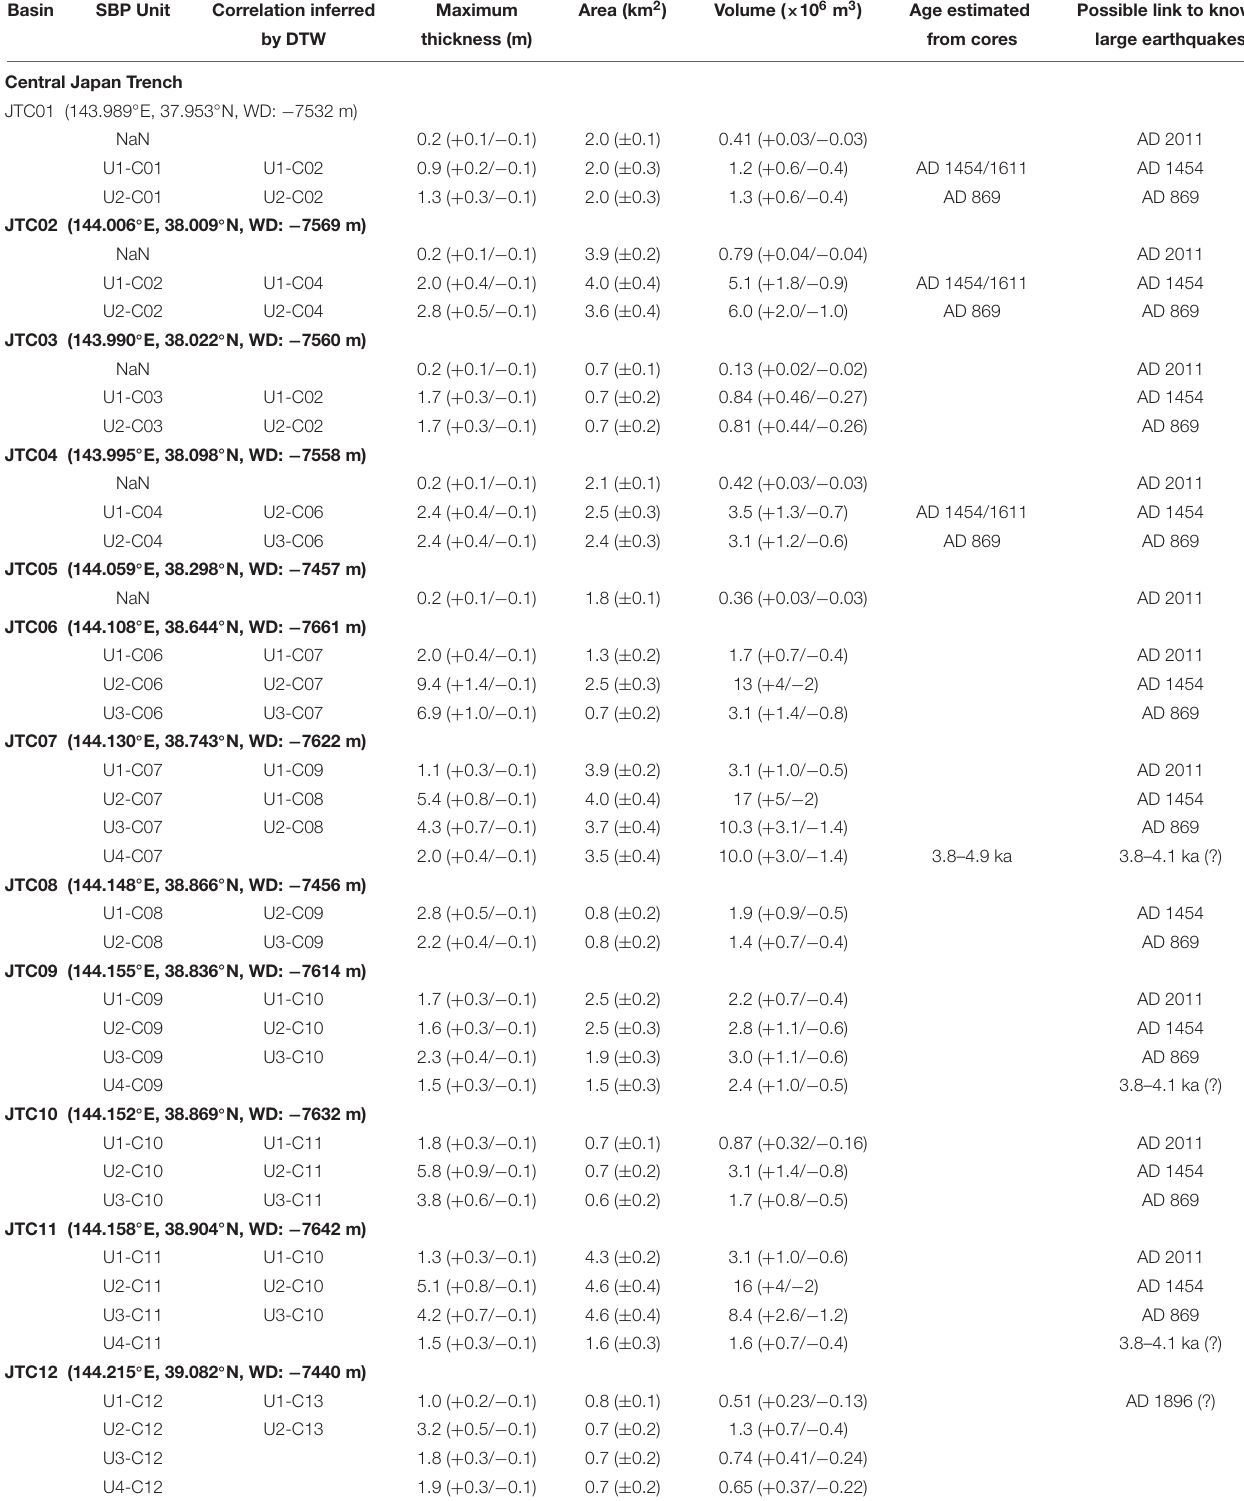
TABLE 2 | Longitude, latitude and water depth (WD) of modern depocenter, acoustically transparent SBP body units, correlation to neighboring SBP units inferred by DTW, maximum thicknesses, areal extents and volumes of identified event deposits, estimated ages from cores, and possible links to historically known large earthquakes at a given trench fill-basin in the central Japan